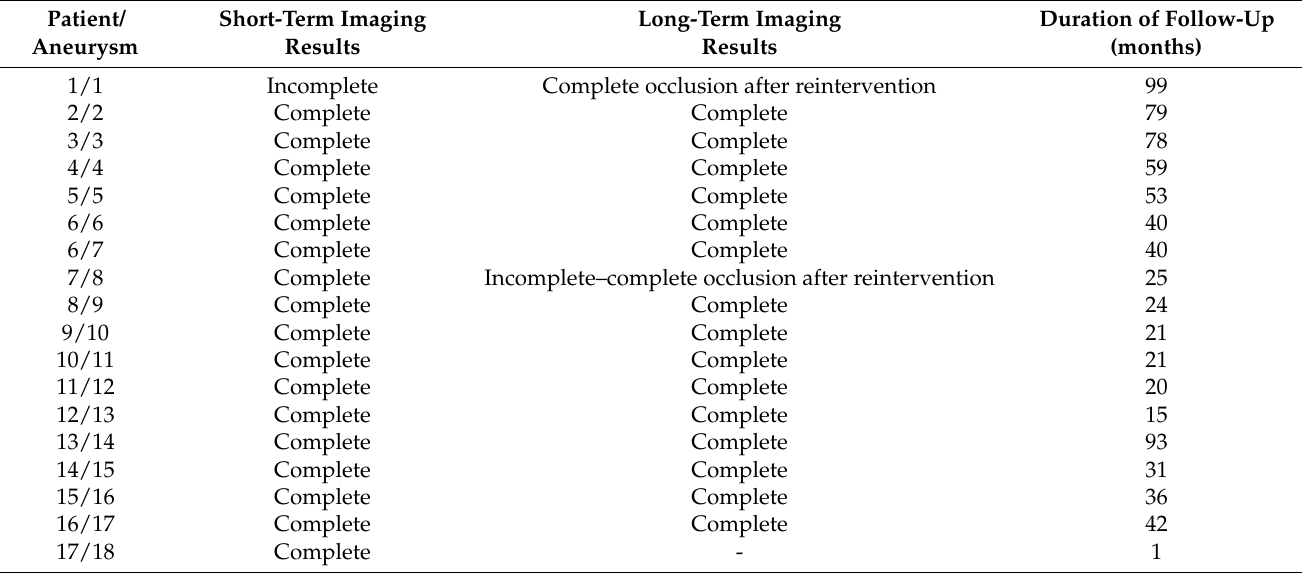
Table 4. Short- and long-term follow-up